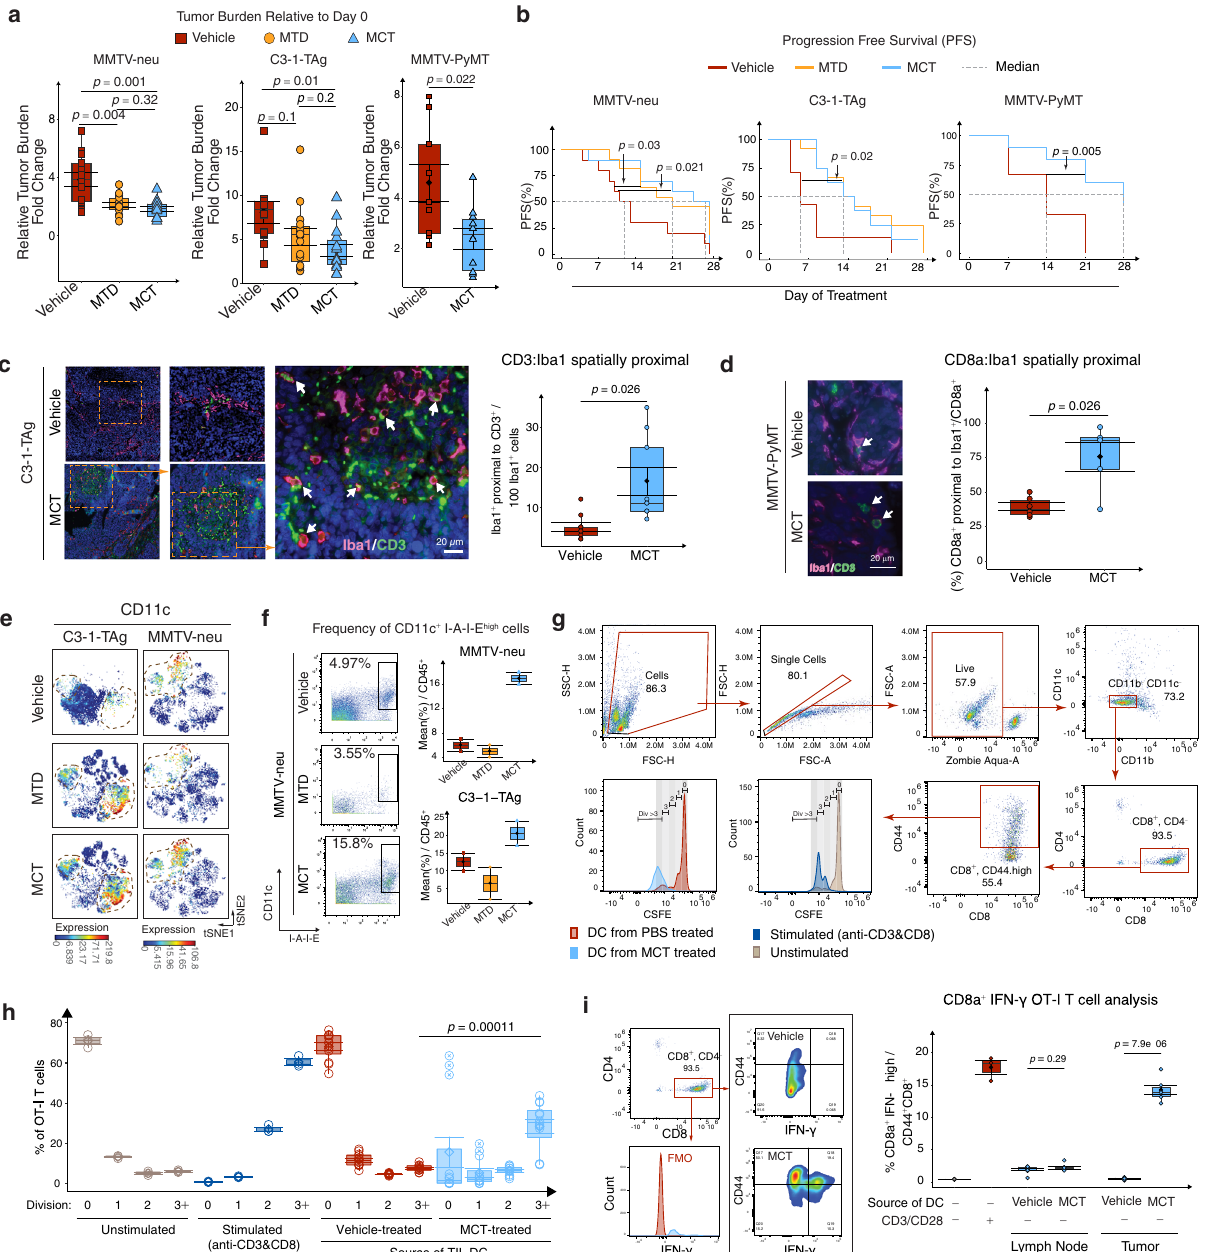
Fig. 1 | MCT increases T - myeloid cell spatial proximity. a MTD=Maximum toleratedDoseandMCT=MetronomicDose.BoxplotsshowtumorburdenonDay 28relativetoDay0oftreatmentinMMTV-neu(left),C3-1-TAg(center),andMMTV- PyMT (right) mice. b PFS (%) indicates the tumor volume doubling time in MMTV- neu (left), C3-1-TAg (center), and MMTV-PyMT (right) (generated using the Survi- mer R package, log rank p -value). a , Immuno fl uorescence b 3 – 5 mice pooled over three cohorts ( n =10 – 13 per group). c Representative IF images of C3-1-TAg breast tumortissuesstainedwithIba1,CD3,andDAPI.Boxplotsquantifyspatialproximity (right) ( n =9 slides per group). d Representative IF images of MMTV-PyMT breast tumor tissues stained with Iba1, CD8, and DAPI. Box plots quantify Iba1 + and CD8 + cellspatialproximity ( n =5 – 8slides per group). e CyTOFdatat-SNEplots compare